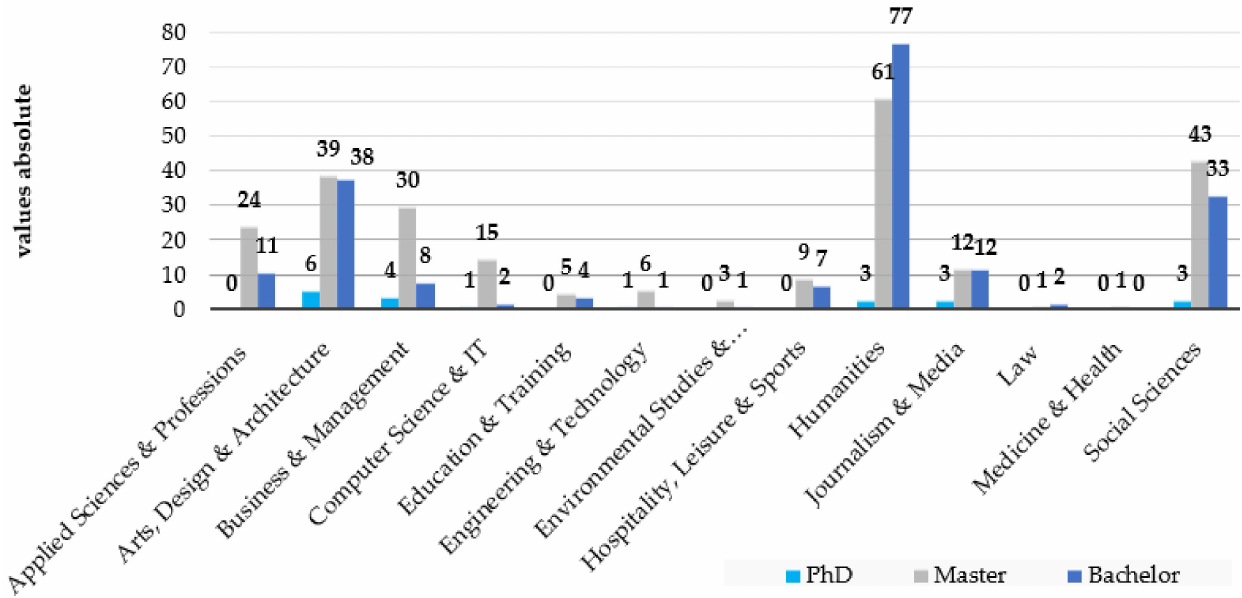
Figure 20. Levels and disciplines of DCH studies in Europe ( n = 267, investigated in